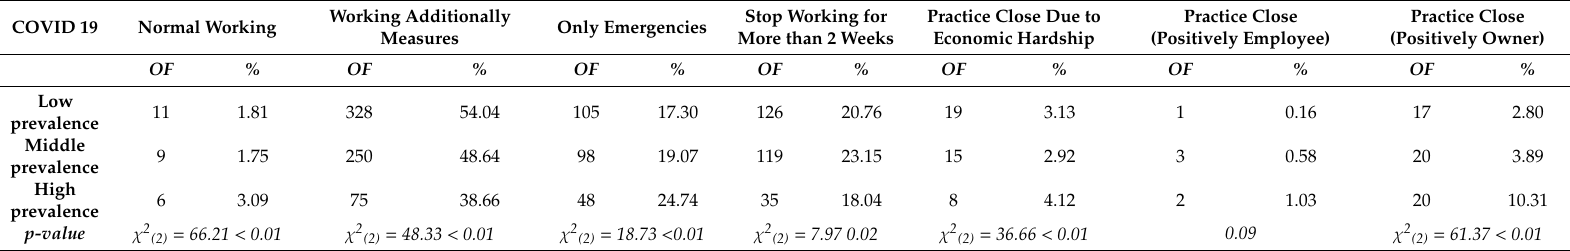
Table 2. Working conditions from the beginning of the COVID 19 pandemic until the beginning of July 2020 (survey time of questionnaire) stratified by Swiss cantons (including the Principality of Liechtenstein) with di ff erent prevalence of the disease. Percentages were calculated per column. COVID 19